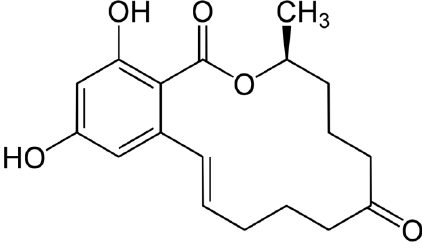
Fig. 2: The structure of zearalenone (Wikipedia public domain)